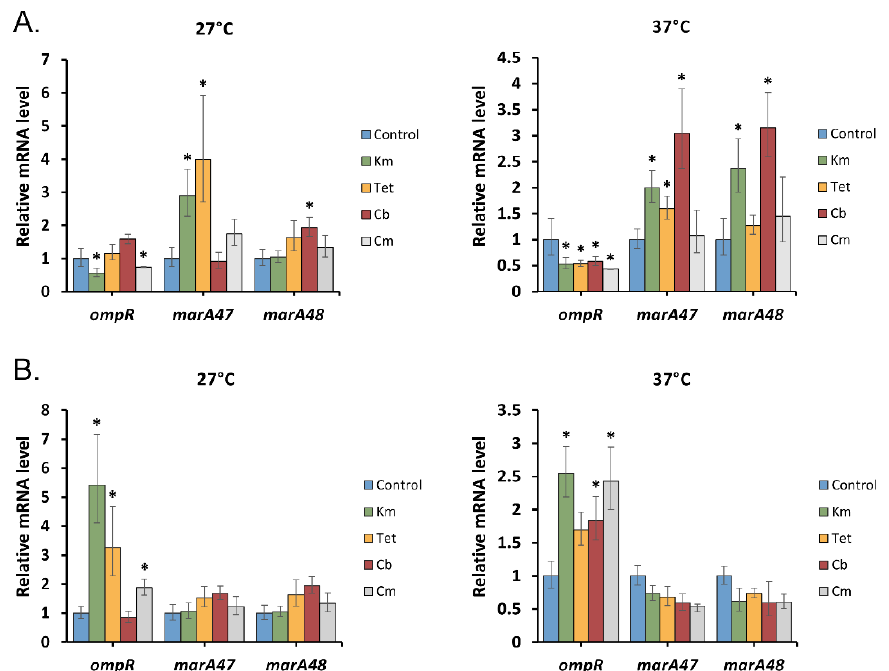
Figure 3. Relative expression levels of Y. pseudotuberculosis ompR , marA47 , and marA48 under antibiotic stress detected by qRT-PCR. ( A ) 1 h antibiotic exposure, ( B ) 16 h antibiotic exposure. All results are expressed as mean ± standard deviation from three independent experiments. An asterisk indicates p -value < 0.05 vs. respective untreated control. Significance was calculated using one-way ANOVA. Km — kanamycin, Tet — tetracycline, Cb — carbenicillin, and Cm — chloramphenicol.